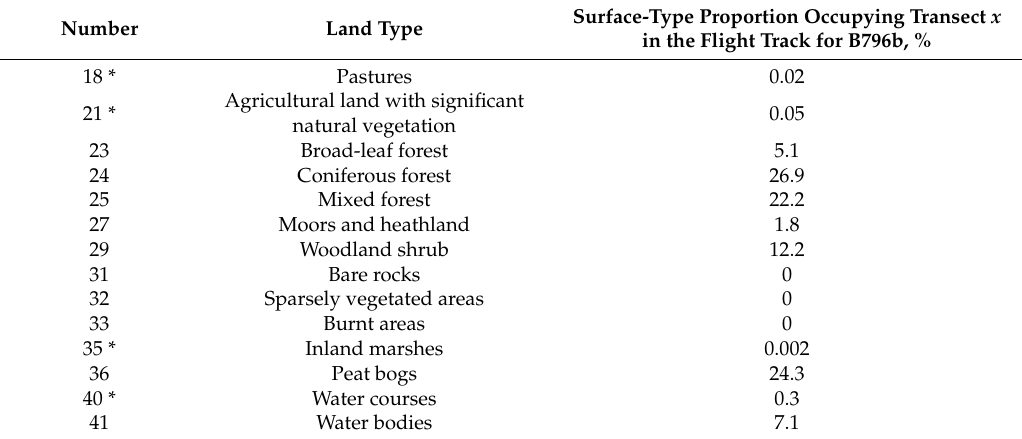
Table 2. The key for the numbers and colours associated with underlying surface-type classification map (Figure 9), which is used to identify prevalent vegetation and land use types within transect x for flight